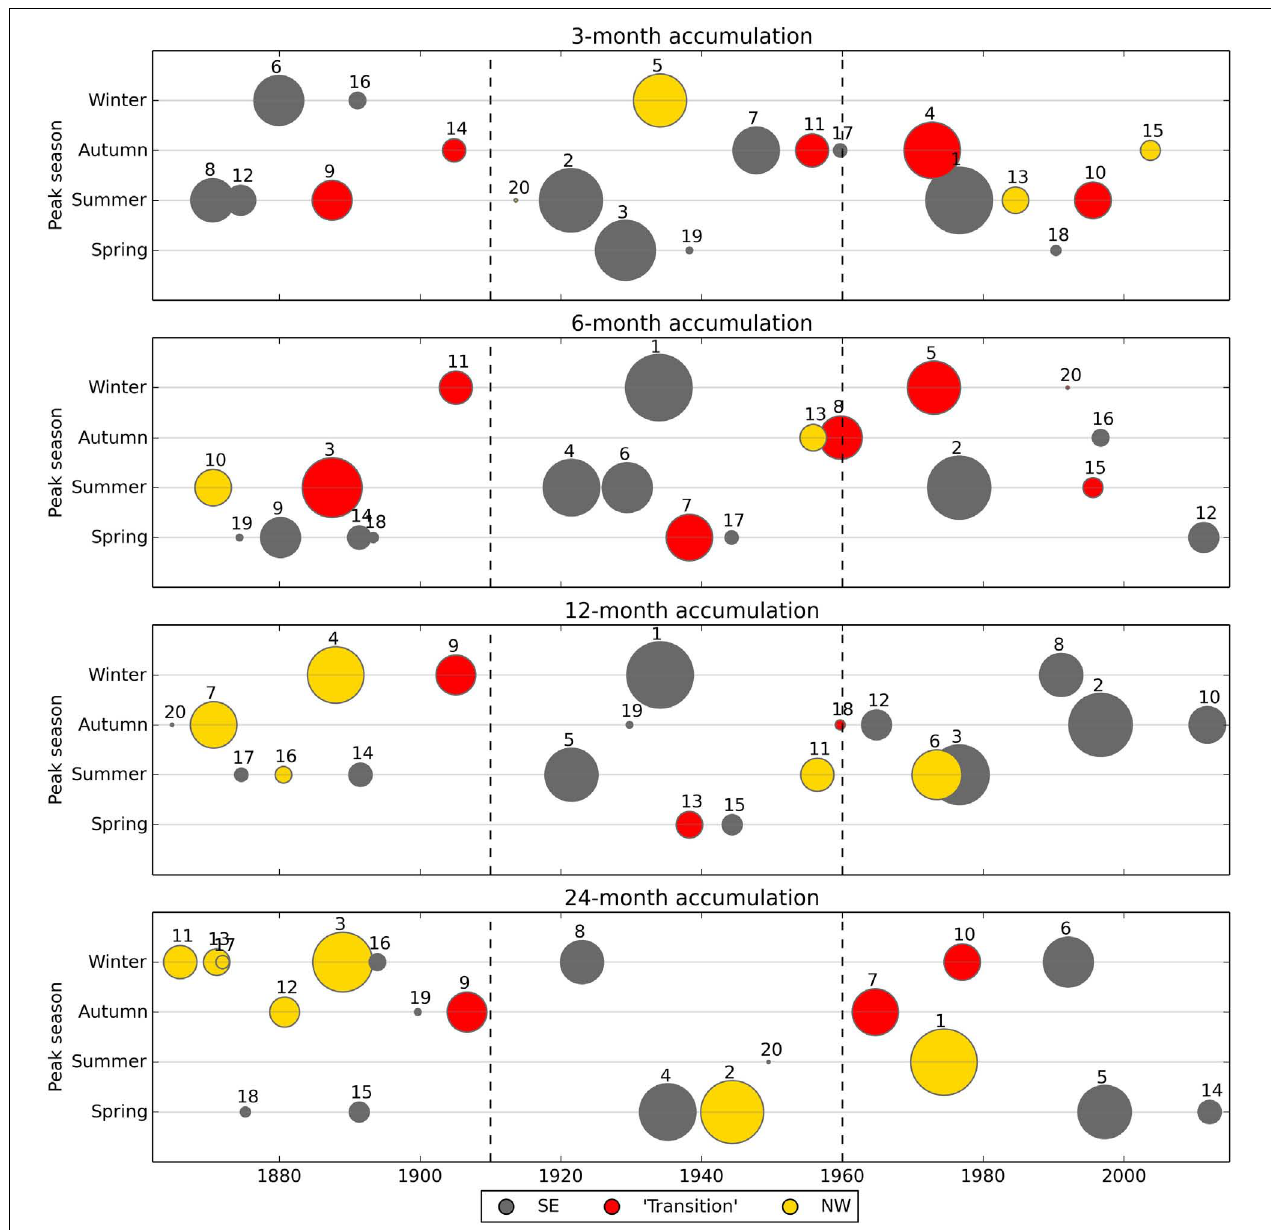
FIGURE 10 | “Top 20” events based on severity for accumulation periods of 3, 6, 12, and 24 months (from top to bottom). The x axis shows the year of the peak of the drought (i.e., when the drought was most intense); the y axis shows the peak season of the drought event; the ranking is shown by the size of the dot (the bigger the dot, the more severe is the drought) and the number on top of each dot; and the colour of the dot indicates the region to which the drought event has been